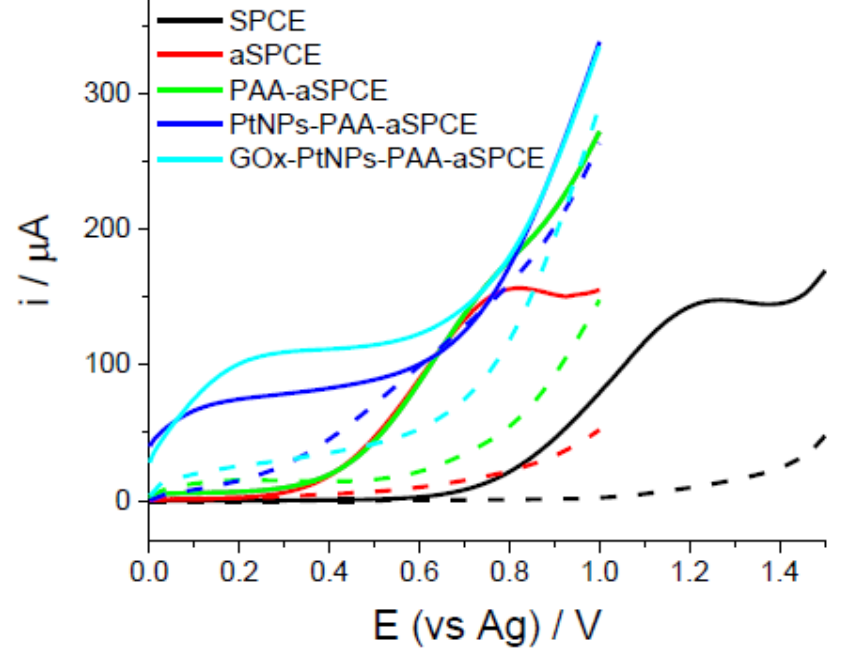
Figure 3. Anodic linear scan voltammetry responss of the different electrode modification steps in the absence (dashed lines) and the presence of 5M of H 2 O 2 (solid lines) in 0.1 M phosphate buffer solution. SPCE: Screen-printed carbon electrodes, aSPCE: activated SPCE, PAA: Poly(Azur A), PtNPs: Platinum Nanoparticles, GOx: glucose oxidase. Reproduced with permission of [108], Copyright 2020, MDPI.